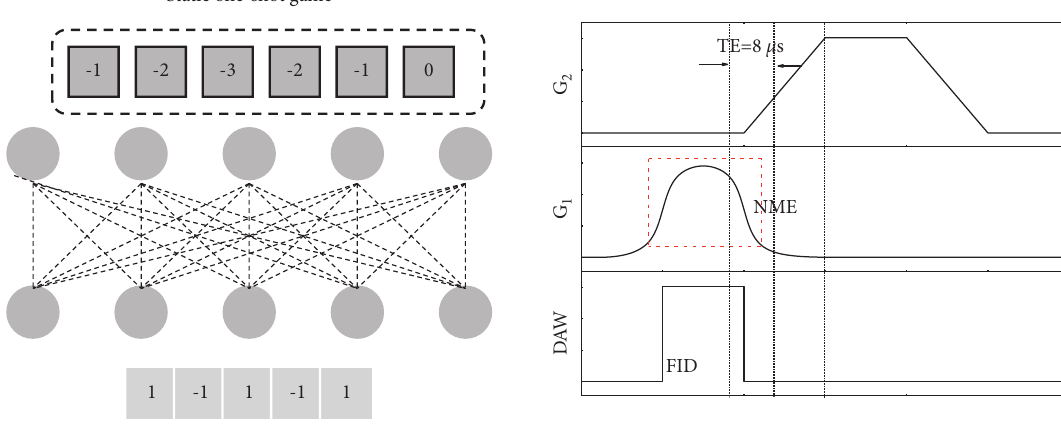
Figure 1: Data transfer in dynamic